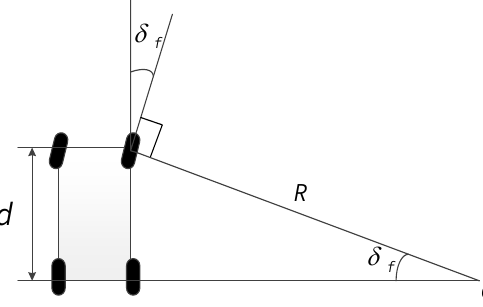
Figure 10. Steering kinematics mode front wheel.